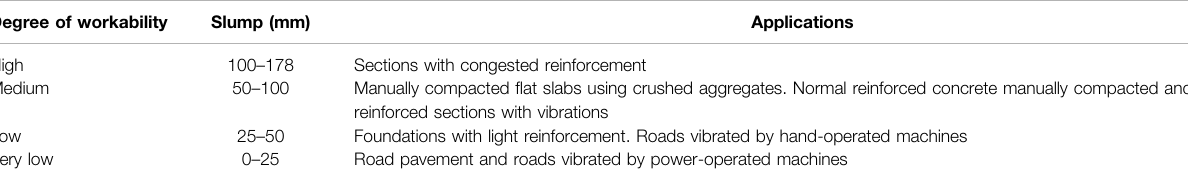
TABLE 3 | Workability, slump, and applications.